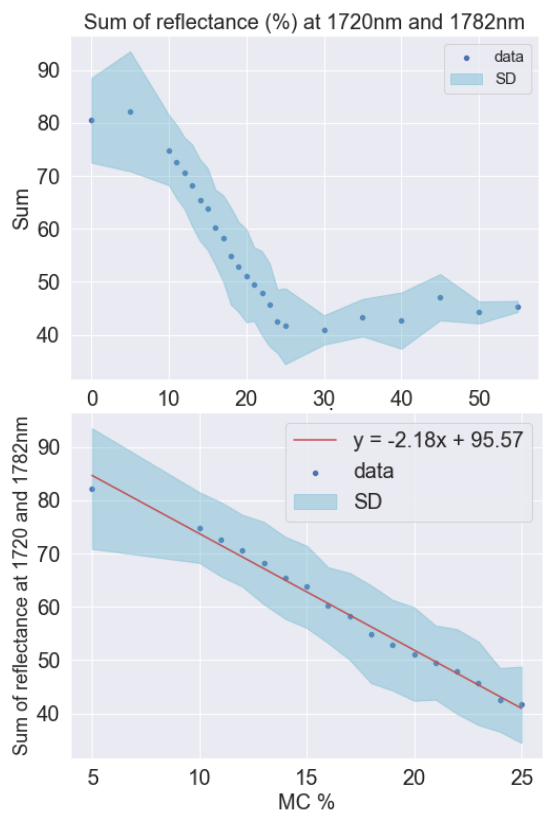
Figure 7(a & b). There is a linear relationship between soil moisture content (y) in the domain of 5–25% MC and the sum (x) of reflectance at 1720 and